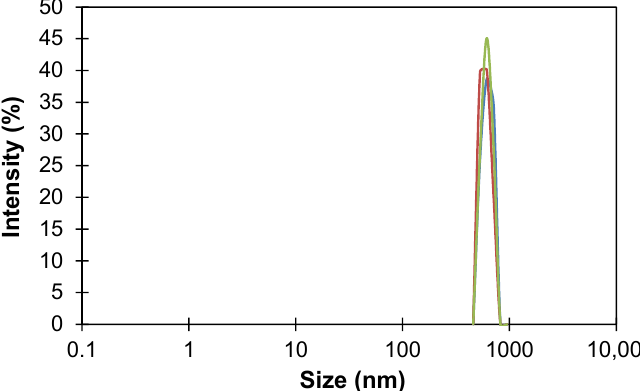
Figure 2. Size distribution of HCPS MN200 in chloroform.